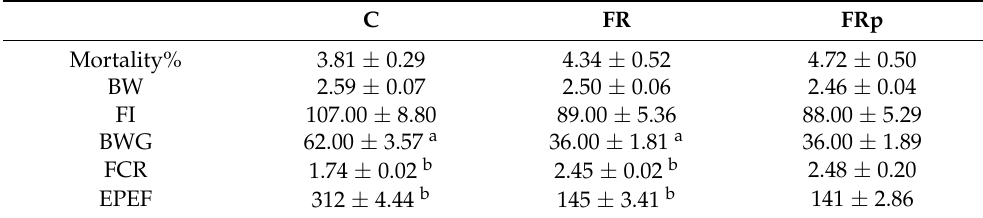
Table 2. Performance analysis of the three tested groups. Values are shown as X ±